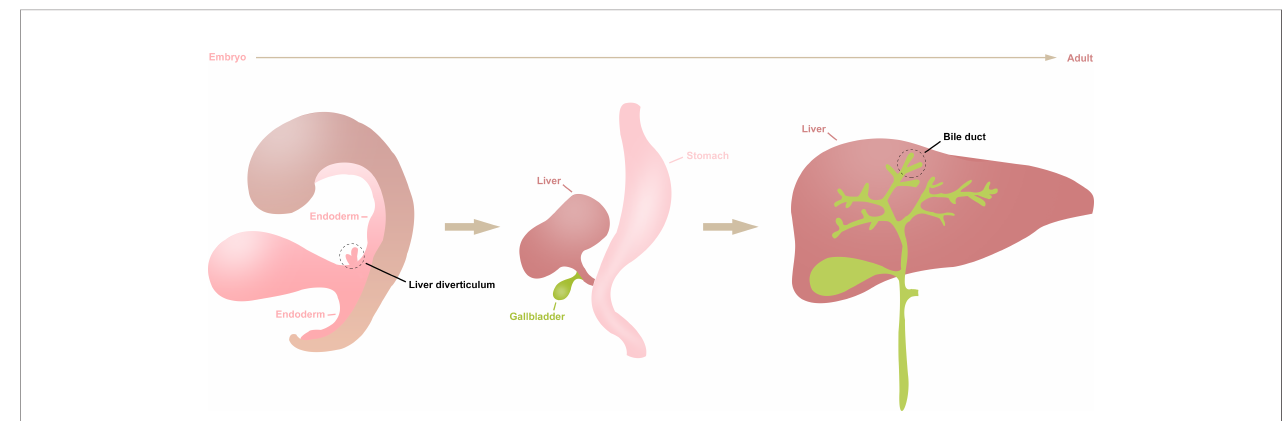
FIGURE 1 | The differentiation of liver diverticulum. The liver and intrahepatic bile duct arise from the liver diverticulum of the endoderm during early embryogenesis, then gradually differentiate into mature organs during human growth and